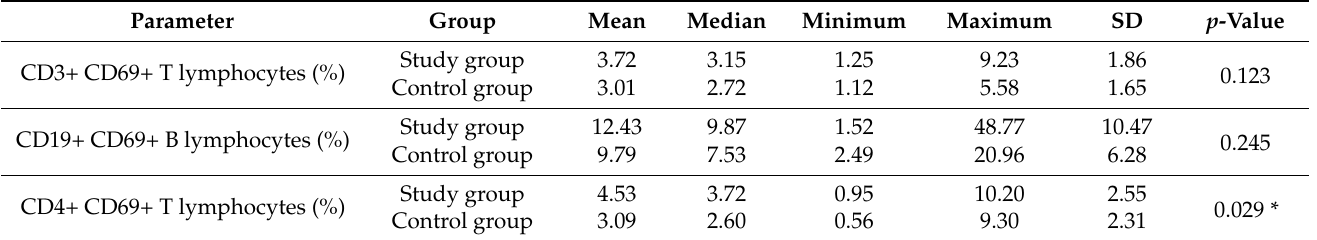
Table 2. Percentage of T and B lymphocytes expressing the CD69 antigen in the study group and the control